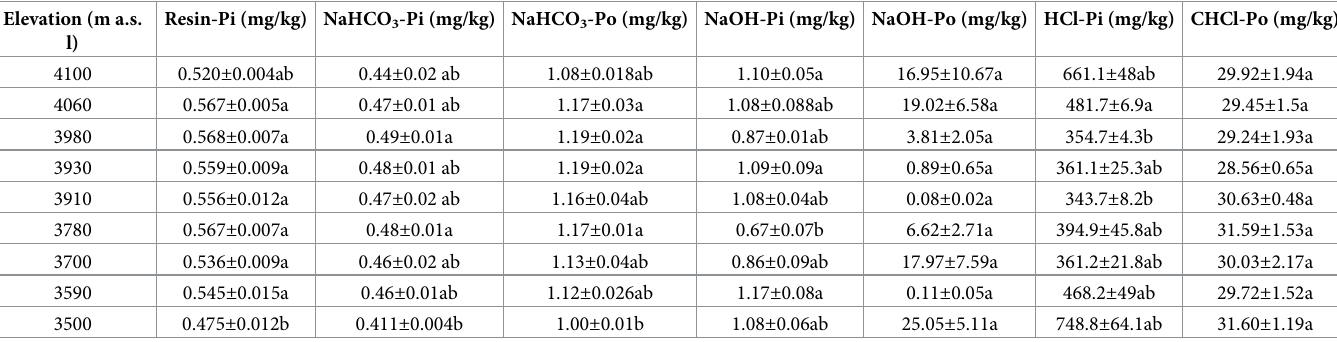
Table 2. Concentrations of P fractions with